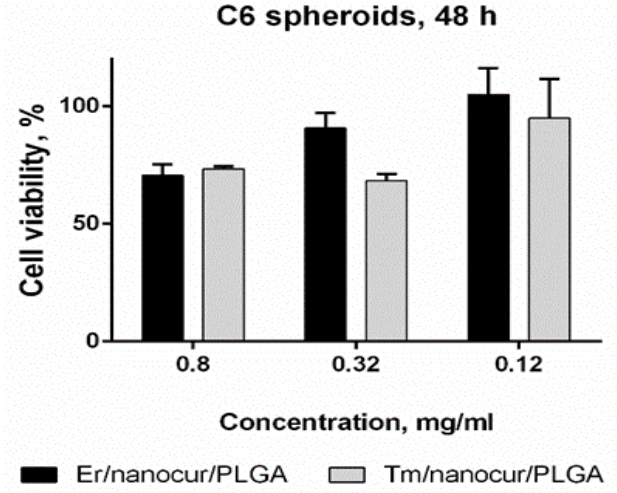
Figure 8. Viability of C6 cells in spheroids after 48 h of incubation with NaYF 4 :Yb,Er-PLGA-nanocur and NaYF 4 :Yb,Tm-PLGA-nanocur. MTS assay, the viability of intact cells was taken as 100%.